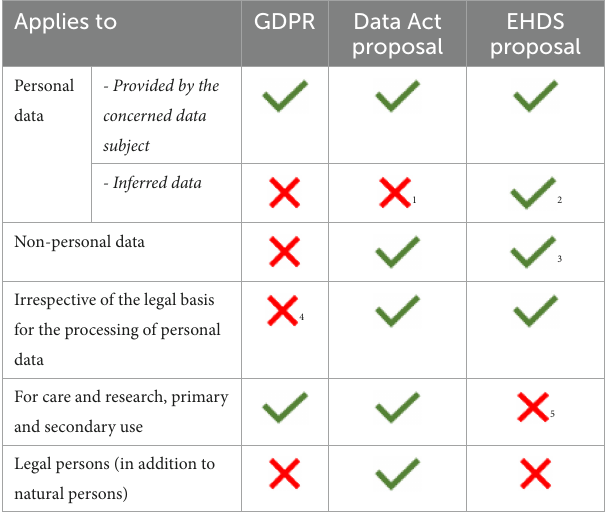
TABLE 2 The three versions of the data portability right, as established in the GDPR (Article 20), the Data Act proposal (Article 4), and the EHDS proposal (Article